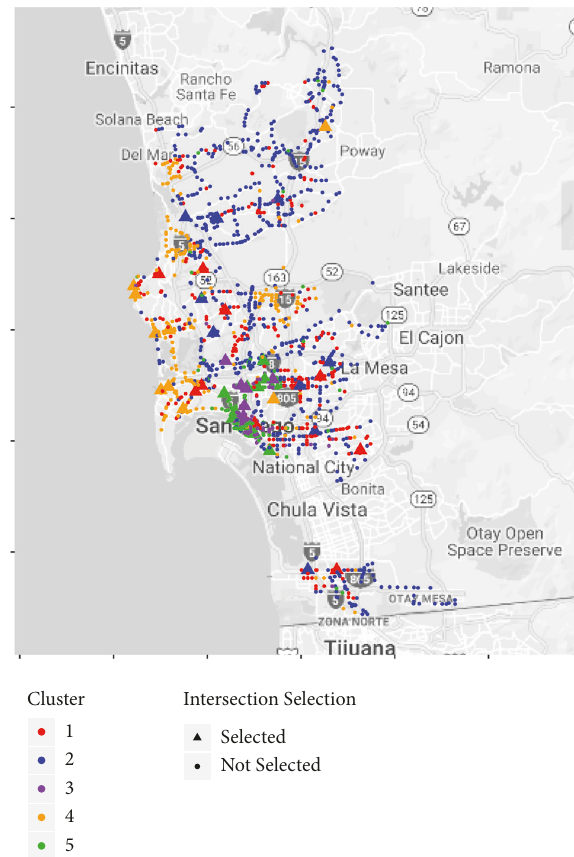
Figure 2: Site selection results by cluster analysis and stratification: triangular shapes are the 45 selected